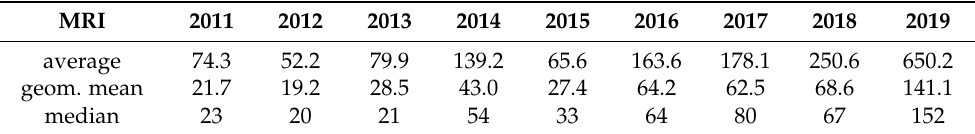
Table 3. Average, geometric mean and median MRI dataset sizes (number of subjects) used in MICCAI articles in each of the years 2011–2019.